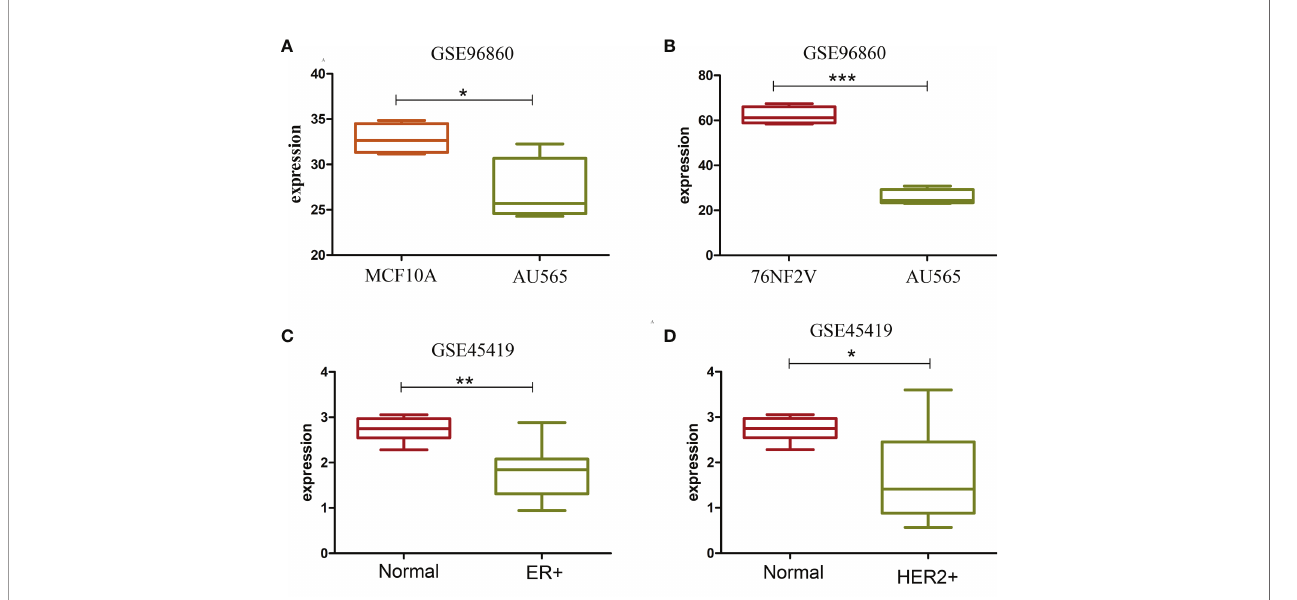
FIGURE 3 | Box plot of TP53 with signi fi cantly different expression in two datasets. (A) TP53 expression in MCF10A and AU565 (HER2+) cells. (B) TP53 expression in 76NF2V and AU565 (HER2+) cells. (C) TP53 expression in control and ER+ BCa tissues. (D) TP53 expression in control and HERS2+ BCa. * P < 0.05; ** P < 0.01; *** P <